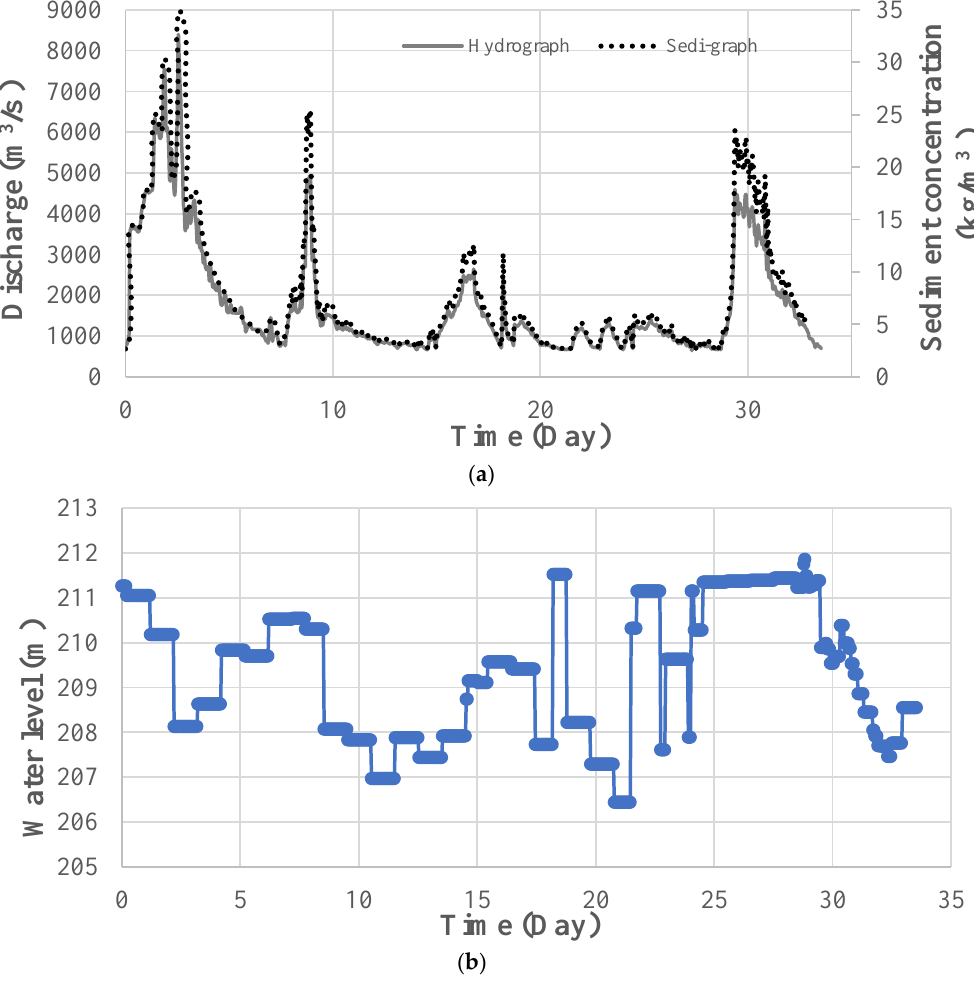
Figure 14. Boundary conditions ( a ) Hydrograph and sedigraph at JiLu Bridge. ( b ) Stage hydrograph at JiJi Weir.